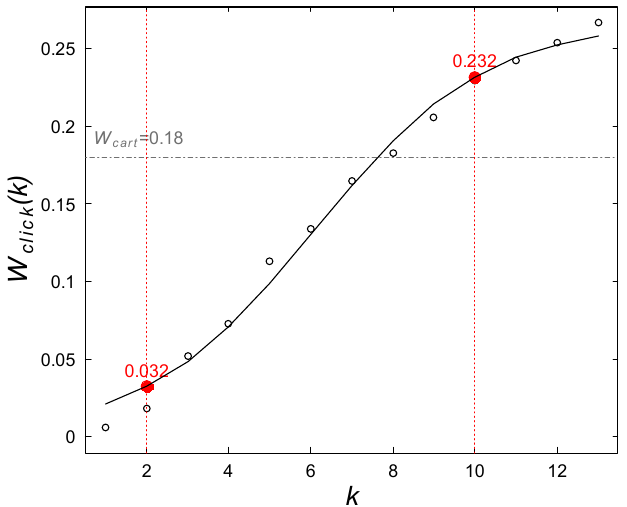
Figure 7. Fitting a sigmoid function of purchase rate to the number of clicks.